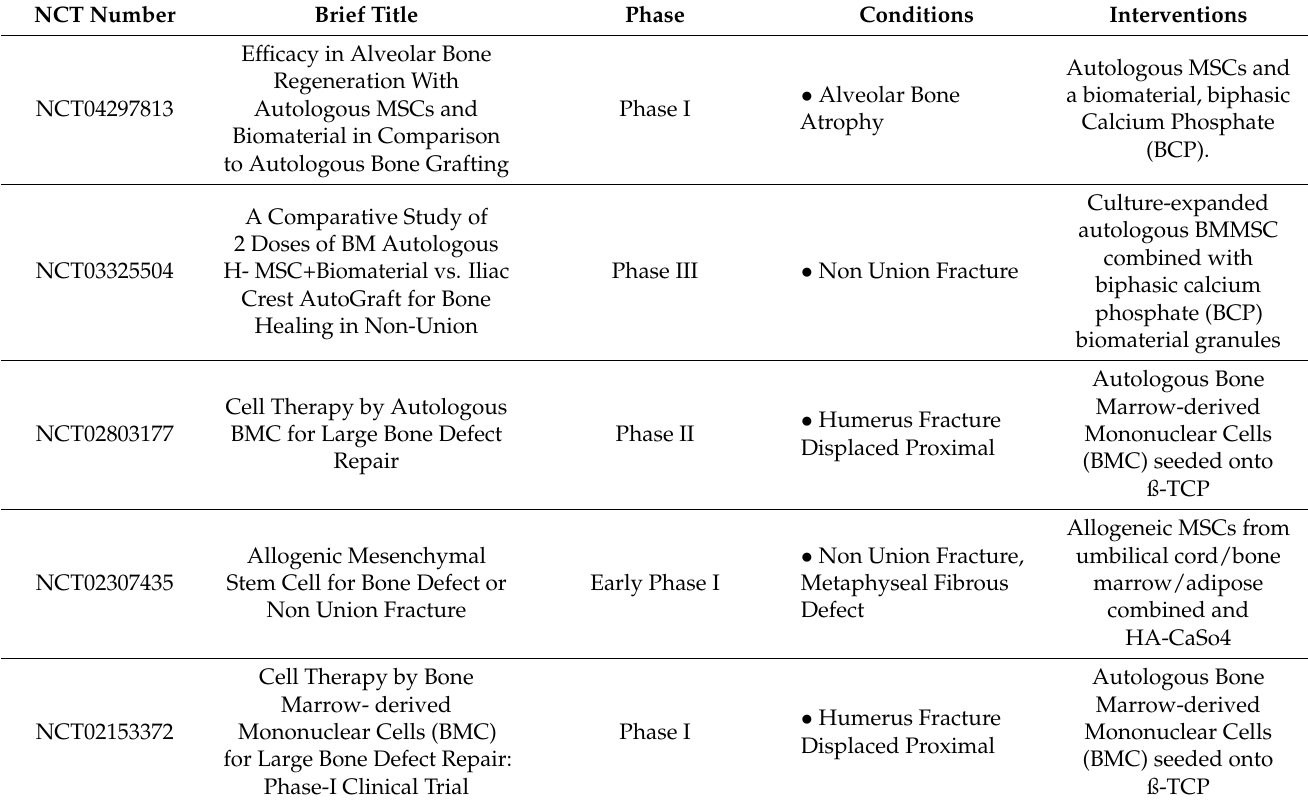
Table 3. List of clinical studies listed in clinicaltraisl.gov using MSCs combined with biomaterials for bone tissue